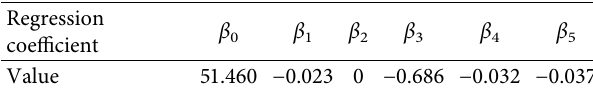
Table 6: Table of regression coefficients for each factor. Regression